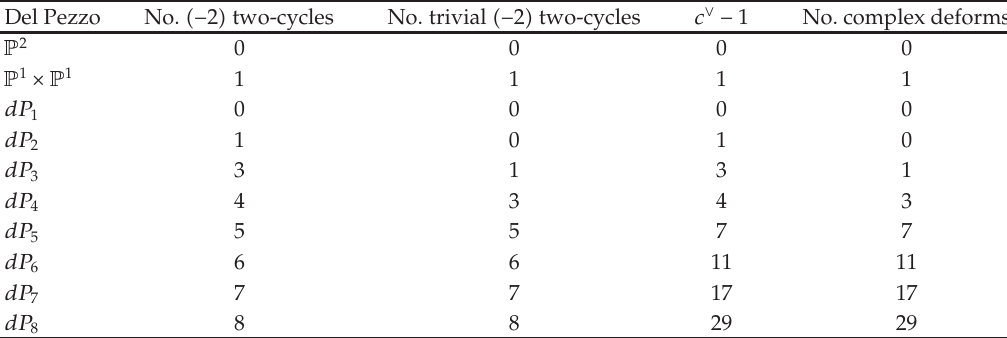
Table 2: Complex deformations of del Pezzo singularities studied in the